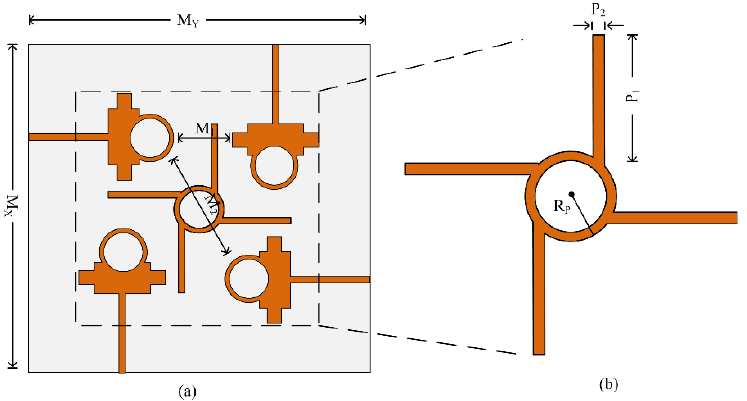
Figure 6. Proposed parasitic element loaded MIMO antenna: ( a ) top view; ( b ) parasitic element.